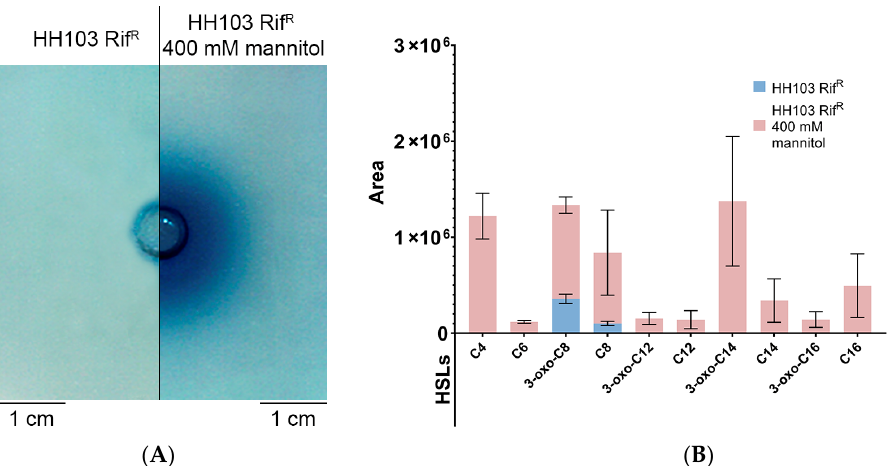
Figure 7. ( A ) Well diffusion assay, using the biosensor A. tumefaciens NT1 (pZRL4), for detection of AHLs produced by S. fredii HH103 grown in TY medium in the absence (left) or presence (right) of 400 mM mannitol. ( B ) Specific AHLs produced by S. fredii HH103 grown in TY medium in the absence (blue) or presence (pink) of 400 mM mannitol, as determined by HPLC-MS/MS.